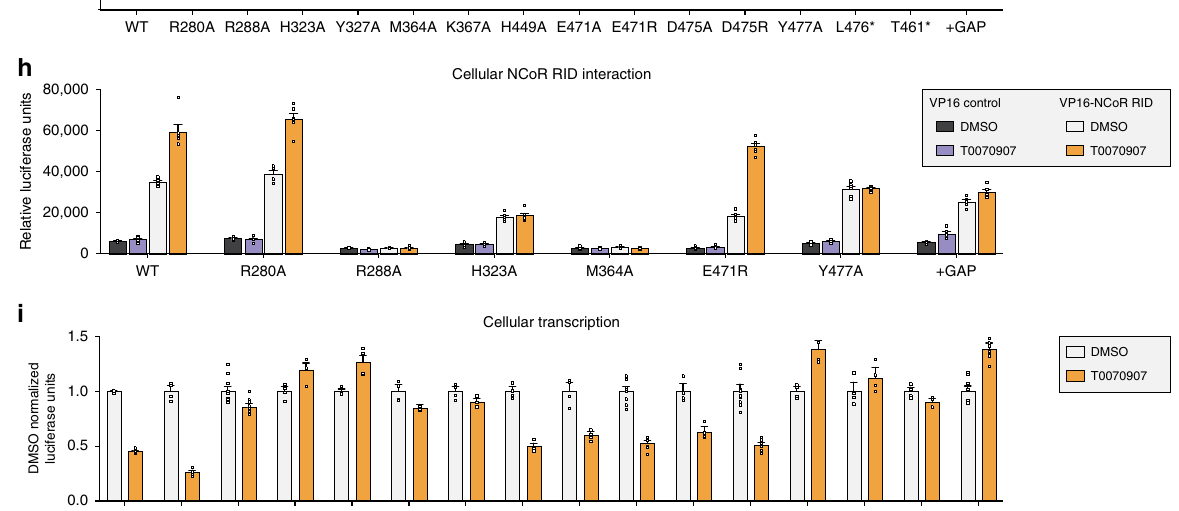
We con fi rmed the TR-FRET and FP biochemical peptide-based fi ndings for several of the mutants using a mammalian two- hybrid protein – protein interaction cellular assay to assess the interaction between the PPAR γ LBD and the entire NCoR RID (Fig. 6h), revealing similar trends to the biochemical data. Two of the mutants (R288A and M364A) show no basal or T0070907- dependent interaction with NCoR RID. Furthermore, the Y477A mutant and + GAP extension maintain basal NCoR